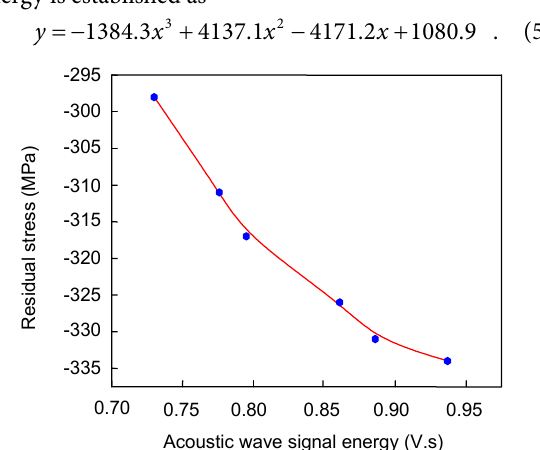
Fig.5 | The relationship between the surface residual stress and acoustic wave signal